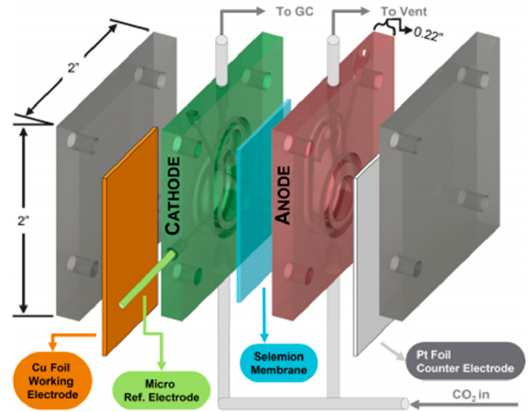
Figure 5. Schematic of a typical home-made electrochemical reactor for liquid-phase CO 2 reduction. A liquid-phase reactor consists of two chambers for the anode and cathode, a membrane, and so on. The volume and area depend on the purpose of the user. Reprinted with permission from the authors of [96].